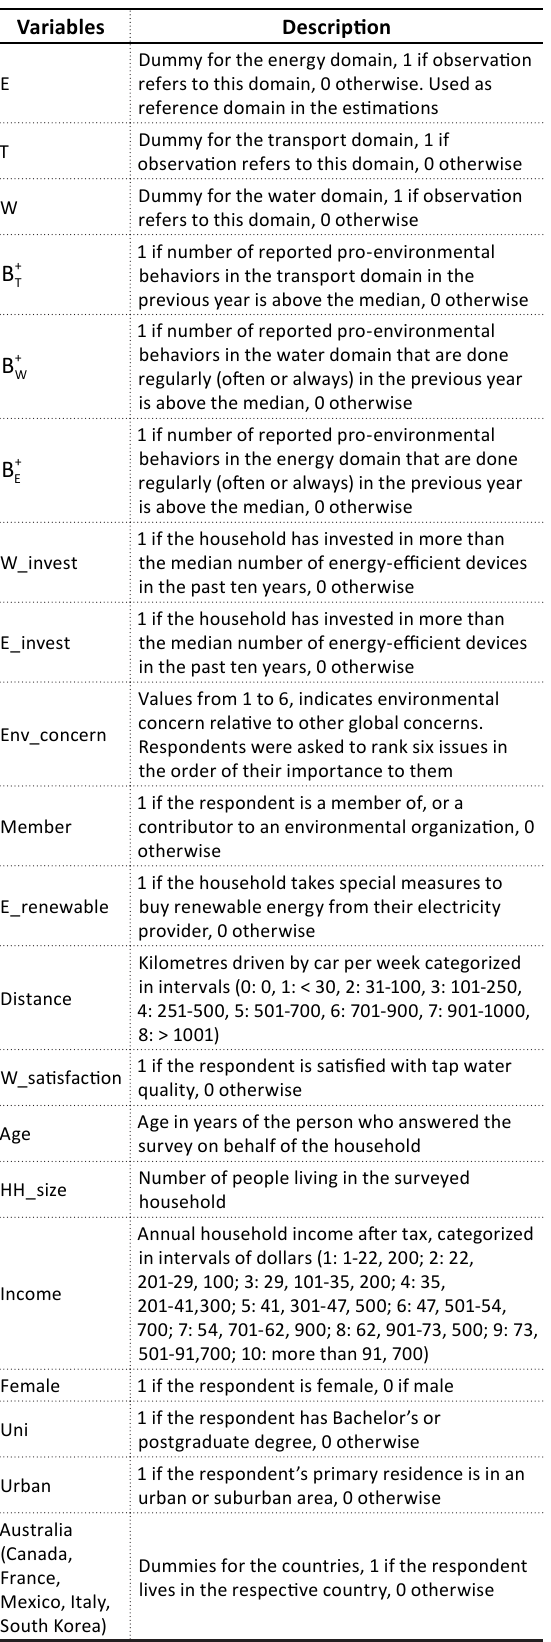
Table 1. Description of variables